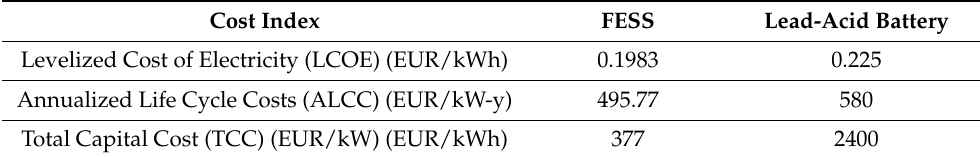
Table 5. Cost comparison for FESS and lead-acid